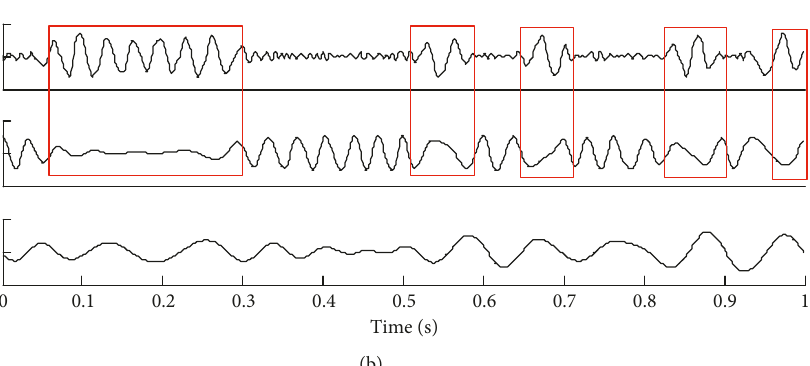
2 ( n ) shown in Figure 6(a) (SNR (cid:29) 5). The